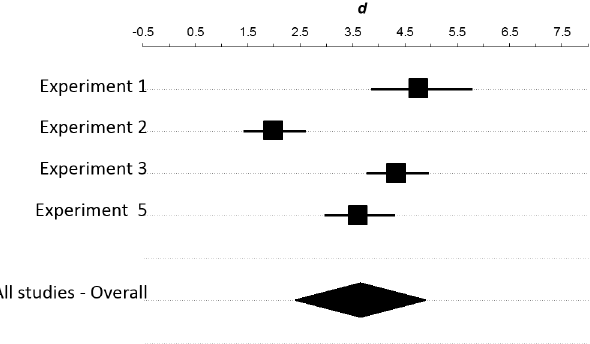
Fig 6. Integration of rated-power manipulation check results across the studies reported in this manuscript. This is not a comprehensive meta-analysis, but simply an integration of results to evaluate consistency and overall effect size. For each experiment, the unbiased effect size is represented by a square scaled to reflect proportionate sample size. The 95% confidence interval for the effect size is represented by a horizontal line. At bottom is shown the overall weighted effect sizes across all studies (black diamond). The center of the diamond represents the estimated effect size, the horizontal span of the diamond represents the 95% confidence interval for that effect. For this analysis, the overall estimate is: d = 3.7, 95% CI [2.4, 4.9]. Note, though, that significant heterogeneity of effect size was observed ( Q (3) = 40.2, p < 0.01) due to the unusually small effect observed in Experiment 2 (difficult golf task). Notably, it was this experiment that had the largest effect we observed on performance. This figure was generated with the Meta-Analysis module in the Exploratory Software for Confidence Intervals package for Microsoft Excel (Cumming,